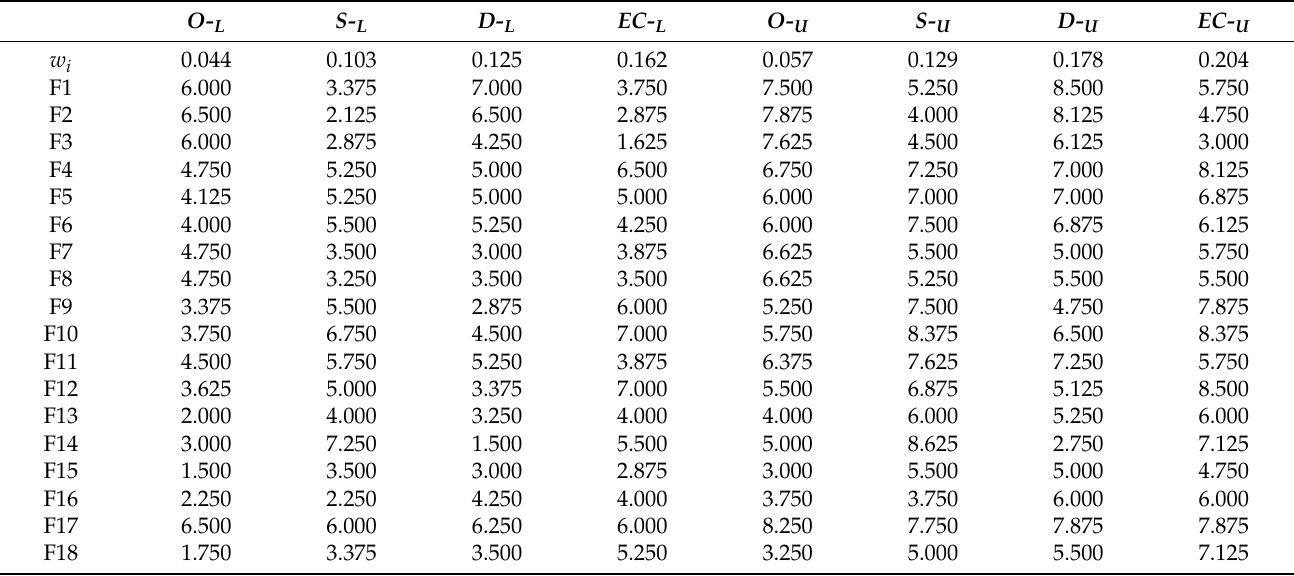
Table 8. Assessment matrix of average score of the eight